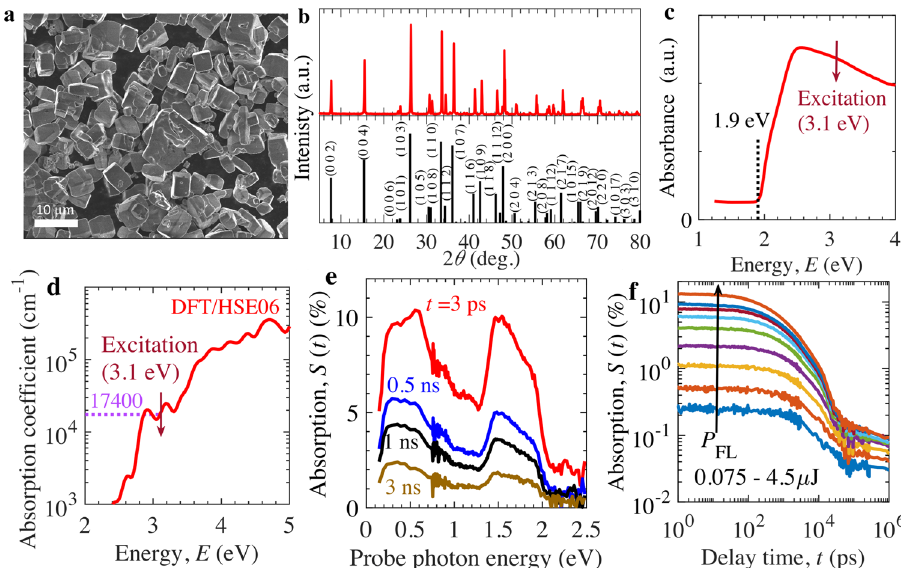
Fig. 1 Morphology, structure, and absorption spectroscopy of Y 2 Ti 2 O 5 S 2 photocatalyst. a SEM image. b XRD pattern (red: measured, black: simulated). c Diffuse re fl ectance spectrum with estimated band-gap energy of 1.9 eV. d Absorption coef fi cient α abs from DFT/HSE06 calculations. e TDR spectra at pump fl uence intensity P FL ¼ 3 μ J. f TDR kinetics at probe photon energy of 0.24 eV. Source data are provided as a Source Data fi le.